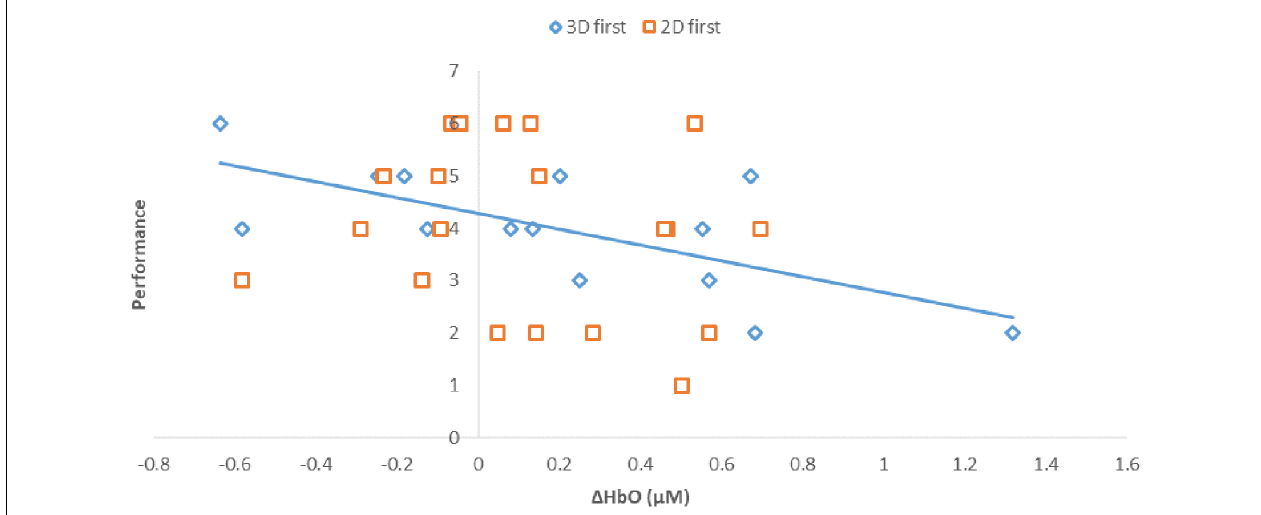
FIGURE 6 | Correlations between performance (# of puzzles attempted to solve) and prefrontal activity ( ∆ HbO, µ M). Regression line shows the strong correlation, r 2 = 0.473, p < 0.01, found in participants that initially performed the 3D condition, shown as 3D first (3D/B1